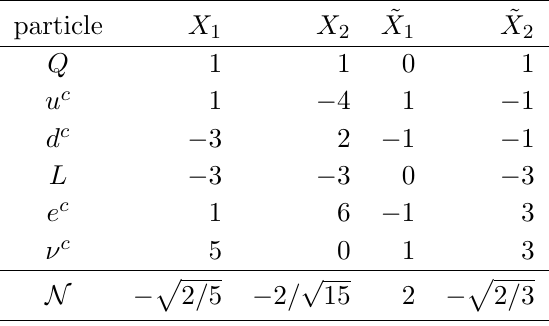
Table 1 . The charges q of di(cid:11)erent VEV alignments X of the 45 on